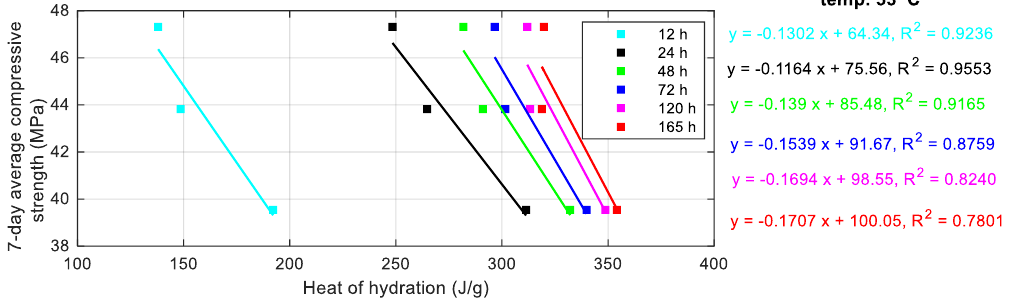
Figure 9. Correlation of 7-day strength and heat of mortars cured at 53 °C.